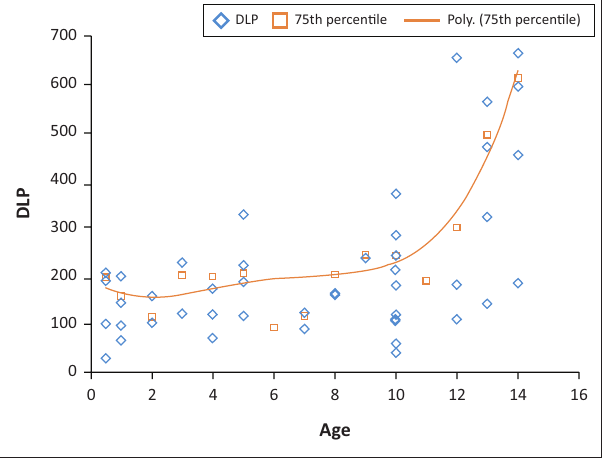
FIGURE 2: Polynomial exponential curve for the purpose of presenting diagnostic reference levels for computed tomography abdomen for specific ages. The data set used in this graph was the dose length product for computed tomography abdomen examinations, corrected for each year in age ( n = 82).